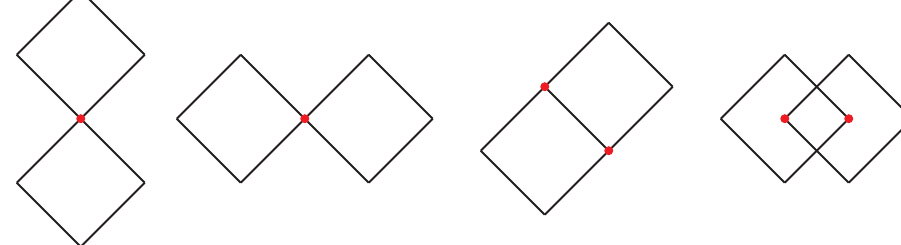
Figure 3: Possibilities for two plaquette operators to share lattice sites (in